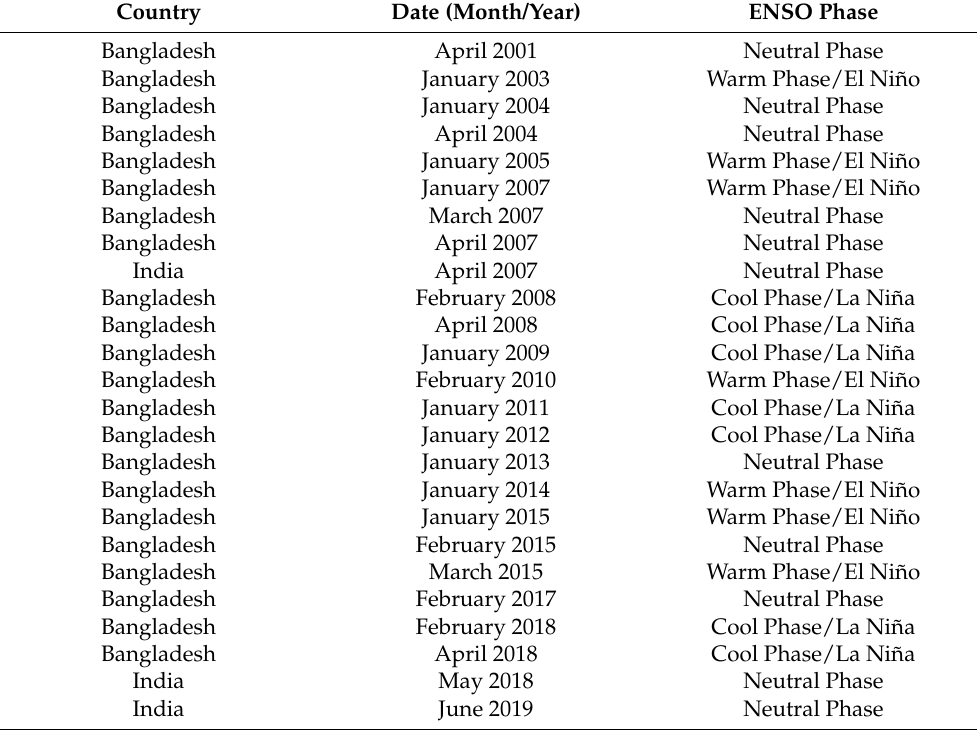
Table 2. Recurring spillover events of the Nipah virus after its first emergence in South Asia (India and Bangladesh) in relation to El Niño Southern Oscillation (ENSO)-driven climate anomalies (data on ENSO were retrieved from NOAA). Data on outbreaks were retrieved from Rahman and